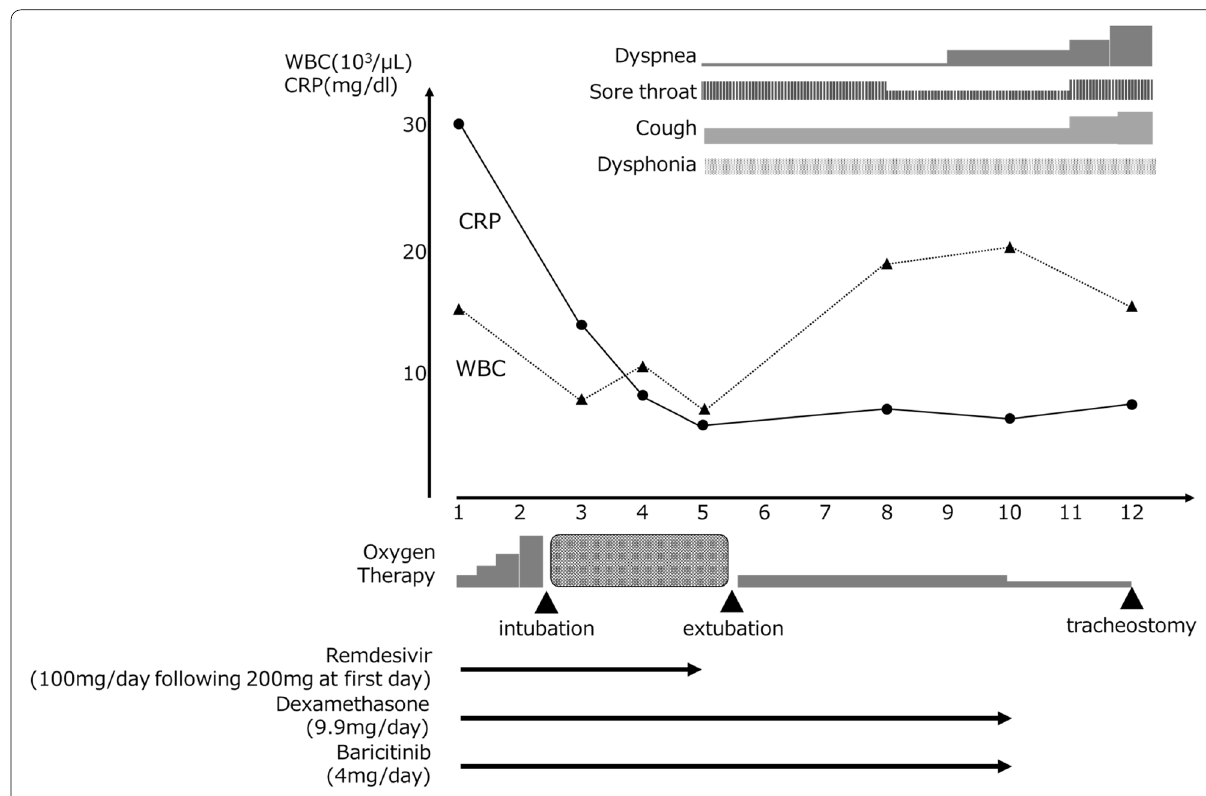
Fig. 1 The course after hospitalization. WBC, white blood cell; CRP, C-reactive